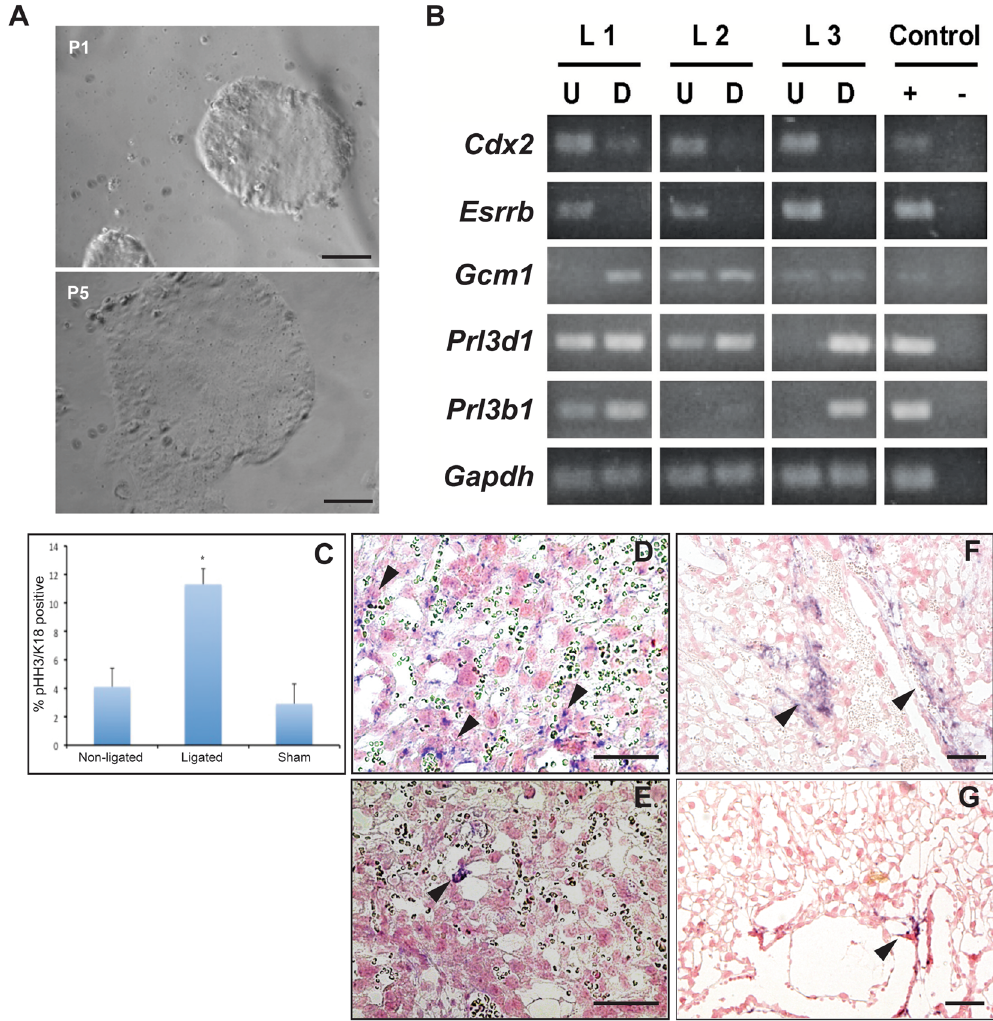
Figure 8. Sca-1 + cells isolated from E11.5 placentae formed proliferating, epithelial-like colonies that could be repeatedly passaged ( A ). When analyzed by RT-PCR, three independent Sca-1-derived colonies expressed genes indicative of trophoblast stem cells ( Cdx2, Esrrb ), syncytiotrophoblast ( Gcm1 ) and trophoblast giant cells ( Prl3d1, Prl3b1 ) ( B ). The frequency of pHH3 + /cytokeratin + trophoblast was increased in the labyrinth layer in response to RUPP ( C ). The expression patterns of Eomes ( D ) and Sca-1 ( F ) were expanded in RUPP placentae ( D,F ) when compared to sham-operated controls ( E , Eomes ; G , Sca-1 ). U and D reflect undifferentiated and differentiated cultures respectively. Scale bar = 100 um. RT-PCR results presented in ( B ) are cropped and organized to be shown as a composite from multiple gel